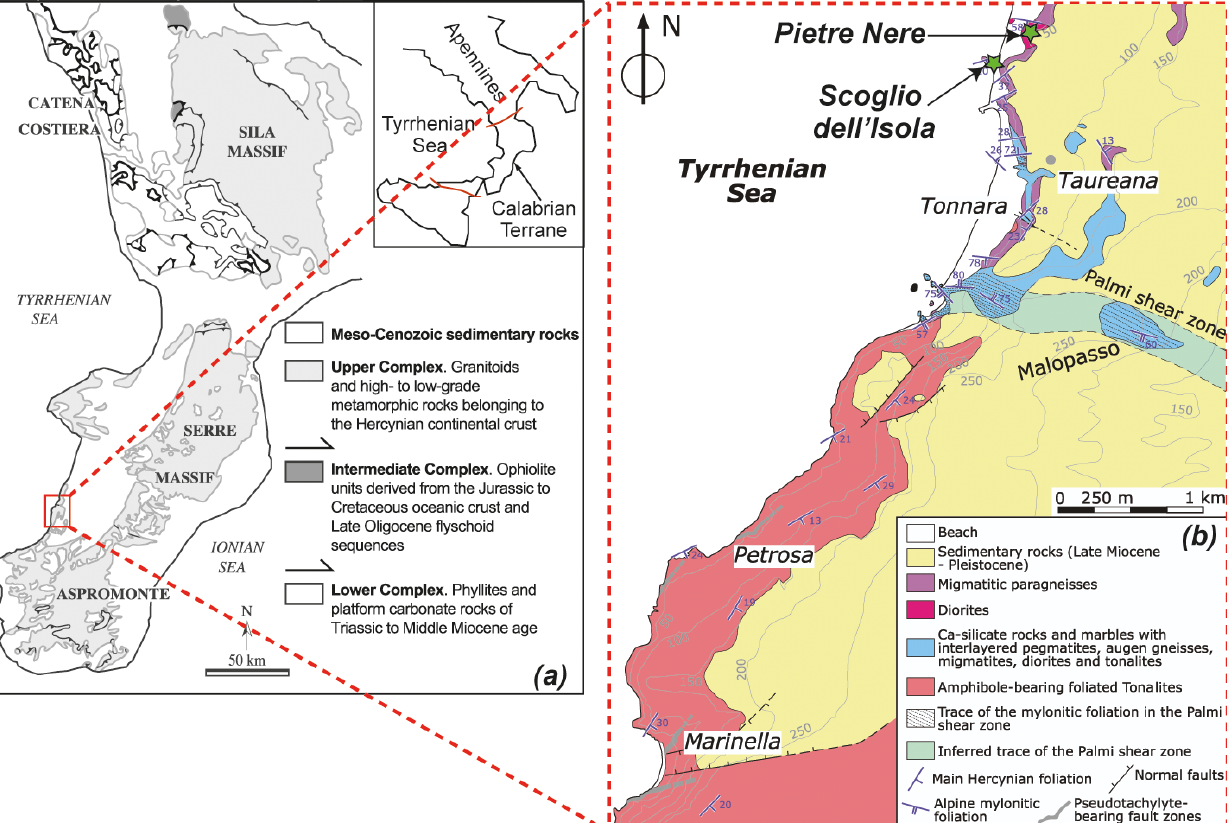
Figure 1. (a) Geological sketch map of Calabria, slightly modified after Festa et al. (2015), and (b) geological sketch map of the Palmi area, slightly modified after Caggianelli et al. (2012), and location of selected samples (green star) at Pietre Nere and Scoglio